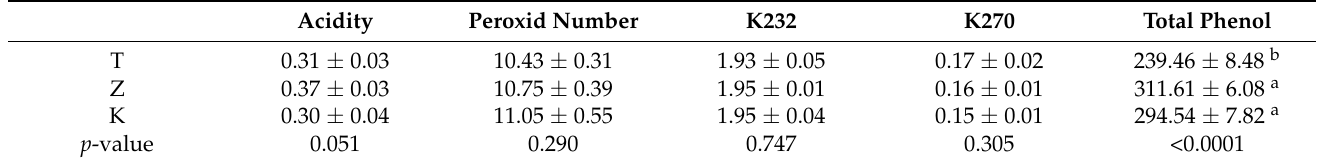
Table 2. Qualitative parameters determined in oils produced under different particle treatments (T = untreated control, Z = zeolitite, K = kaolin). Different letters in the same column